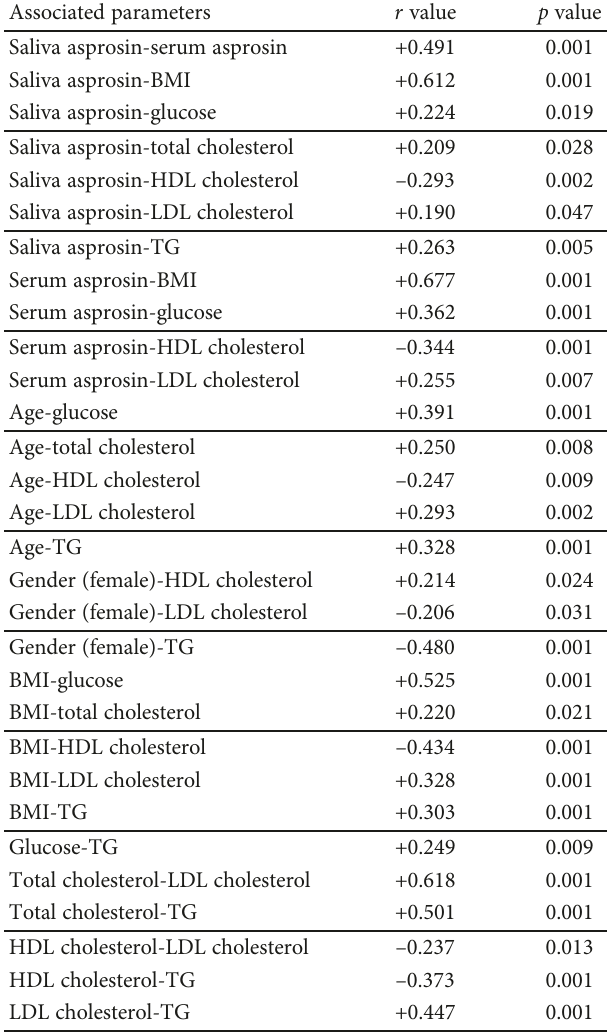
Table 2: Correlations between biochemical parameters and demographic parameters.